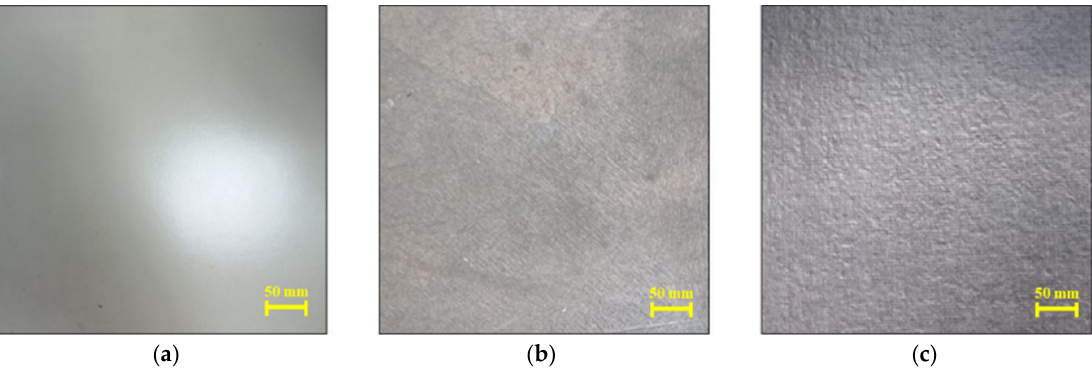
Figure 2. Flooring Surfaces: ( a ) laminate, ( b ) matt, and ( c )